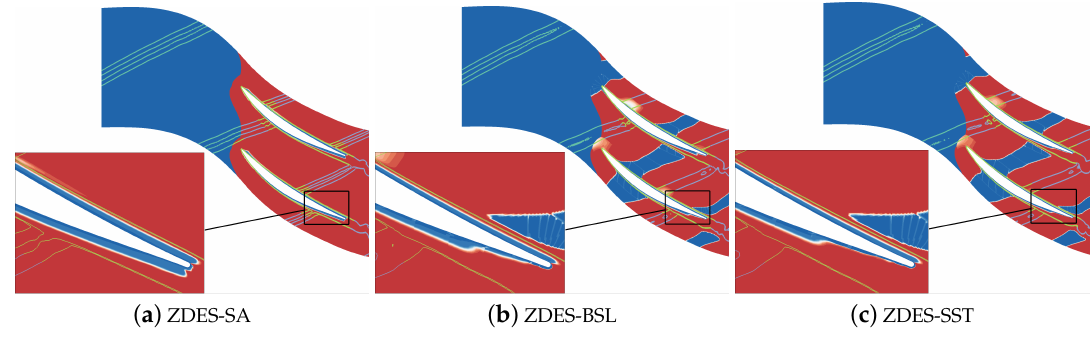
Figure 9. Contours of λ sensor at mid-span at the instant t = T /2 and isolines of entropy variation (to highlight the tip leakage vortex) colored by ZDES